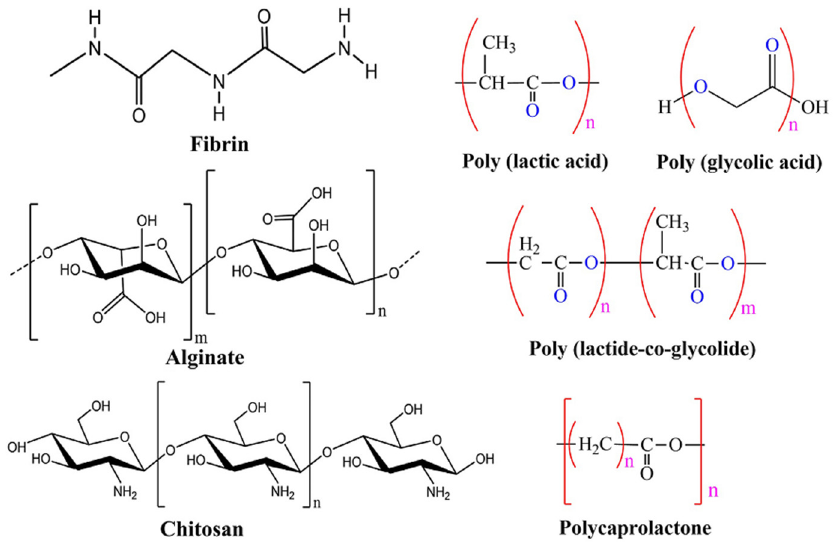
Figure 2. Chemical structures of representative natural and synthetic biomaterials. Reprinted with permission from [27,28]; Copyright 2017&2019 Elsevier.